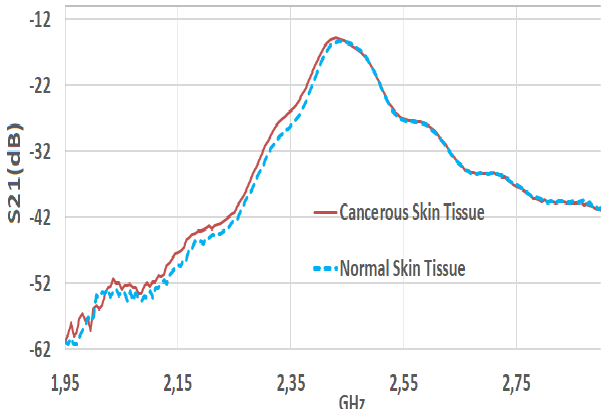
Figure 9: Differences of S 21 values between cancerous and normal tissue obtained from the experimental setup.